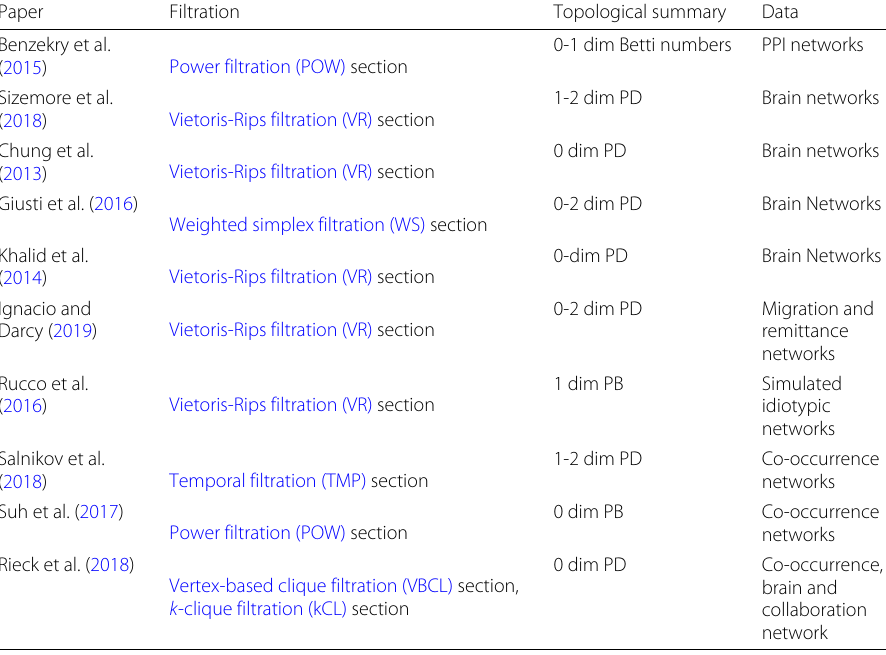
Table 2 The comparison of algorithms and applications on Single